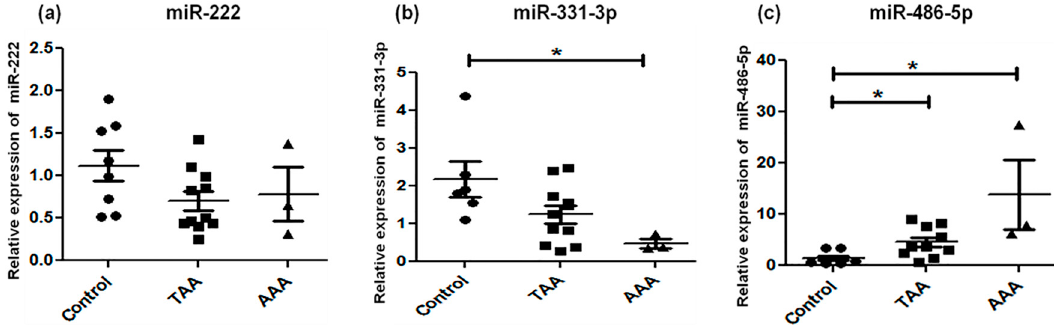
Figure 3. Alteration in microRNA profiles of miR-222 ( a ), miR-331-3p ( b ), and miR-486-5p ( c ) by qRT- PCR. Expression levels in TAA ( n = 11) and AAA ( n = 3) as compared with non-aneurysmal control aorta ( n = 8). The relative amount of each miRNA was normalized to RNU44. Statistically significant differences: * p < 0.05.